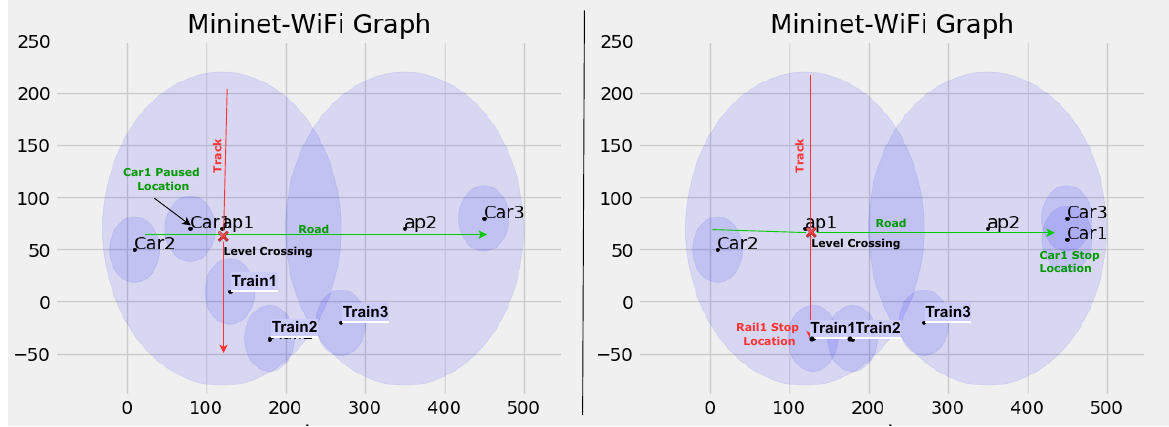
Figure 17. Level crossing scenario.